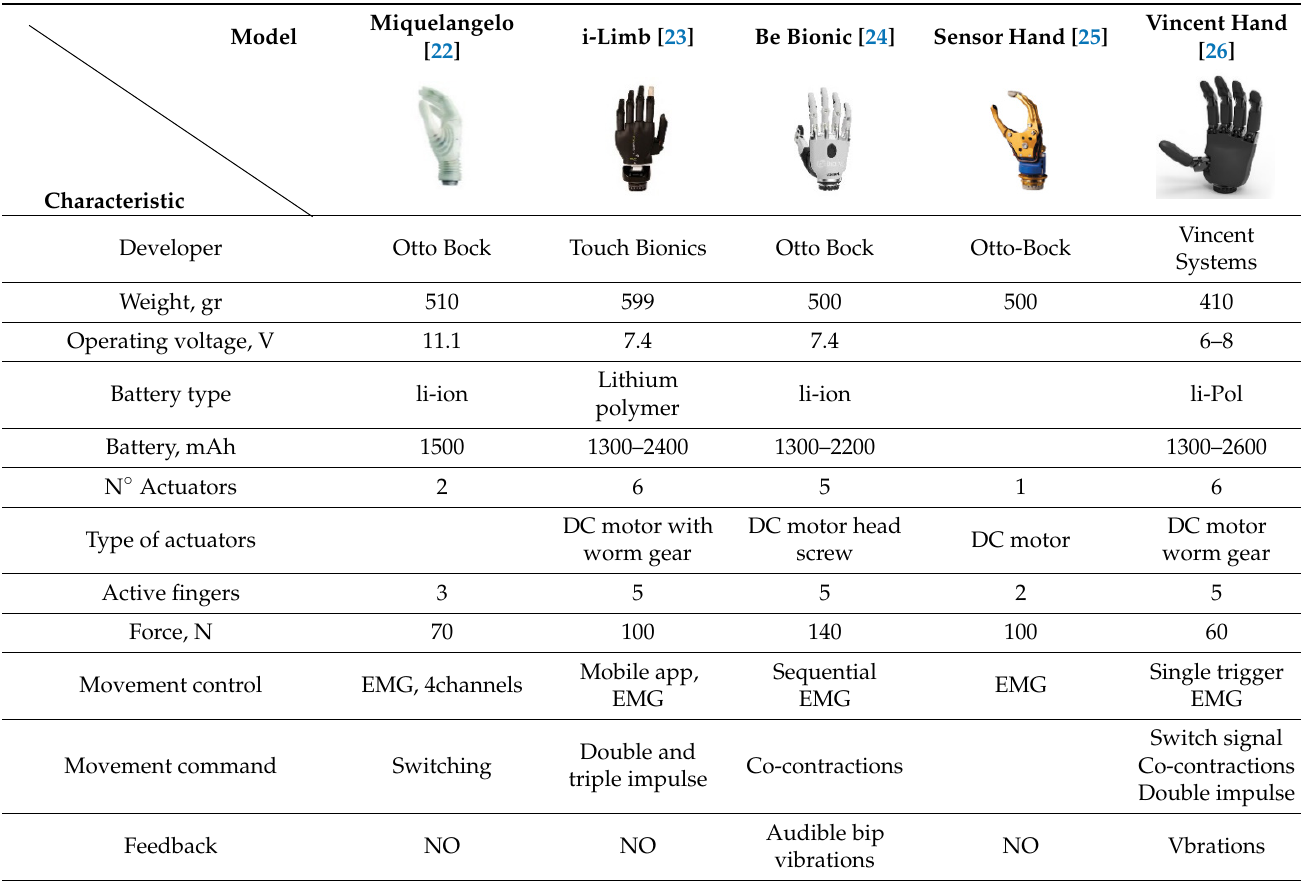
Table 1. Bionic prosthetic hands characteristics.